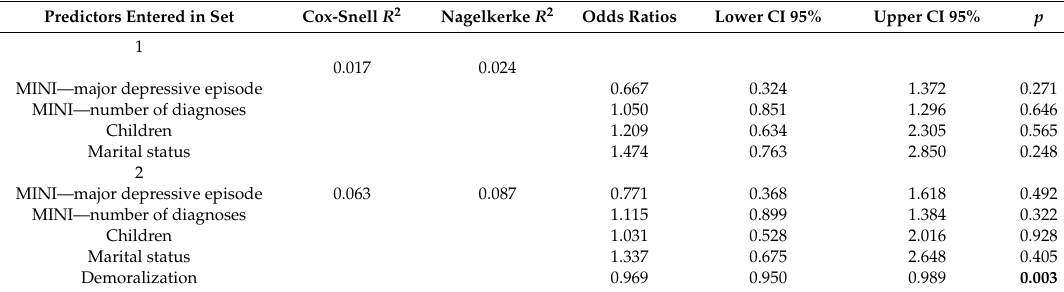
Table 2. Hierarchical multiple logistic regression equation, predicting the probability of being included with suicidal ideation vs. suicide attempt (coding values: 0 = suicidal ideation (n = 131), 1 = suicide attempt (n =